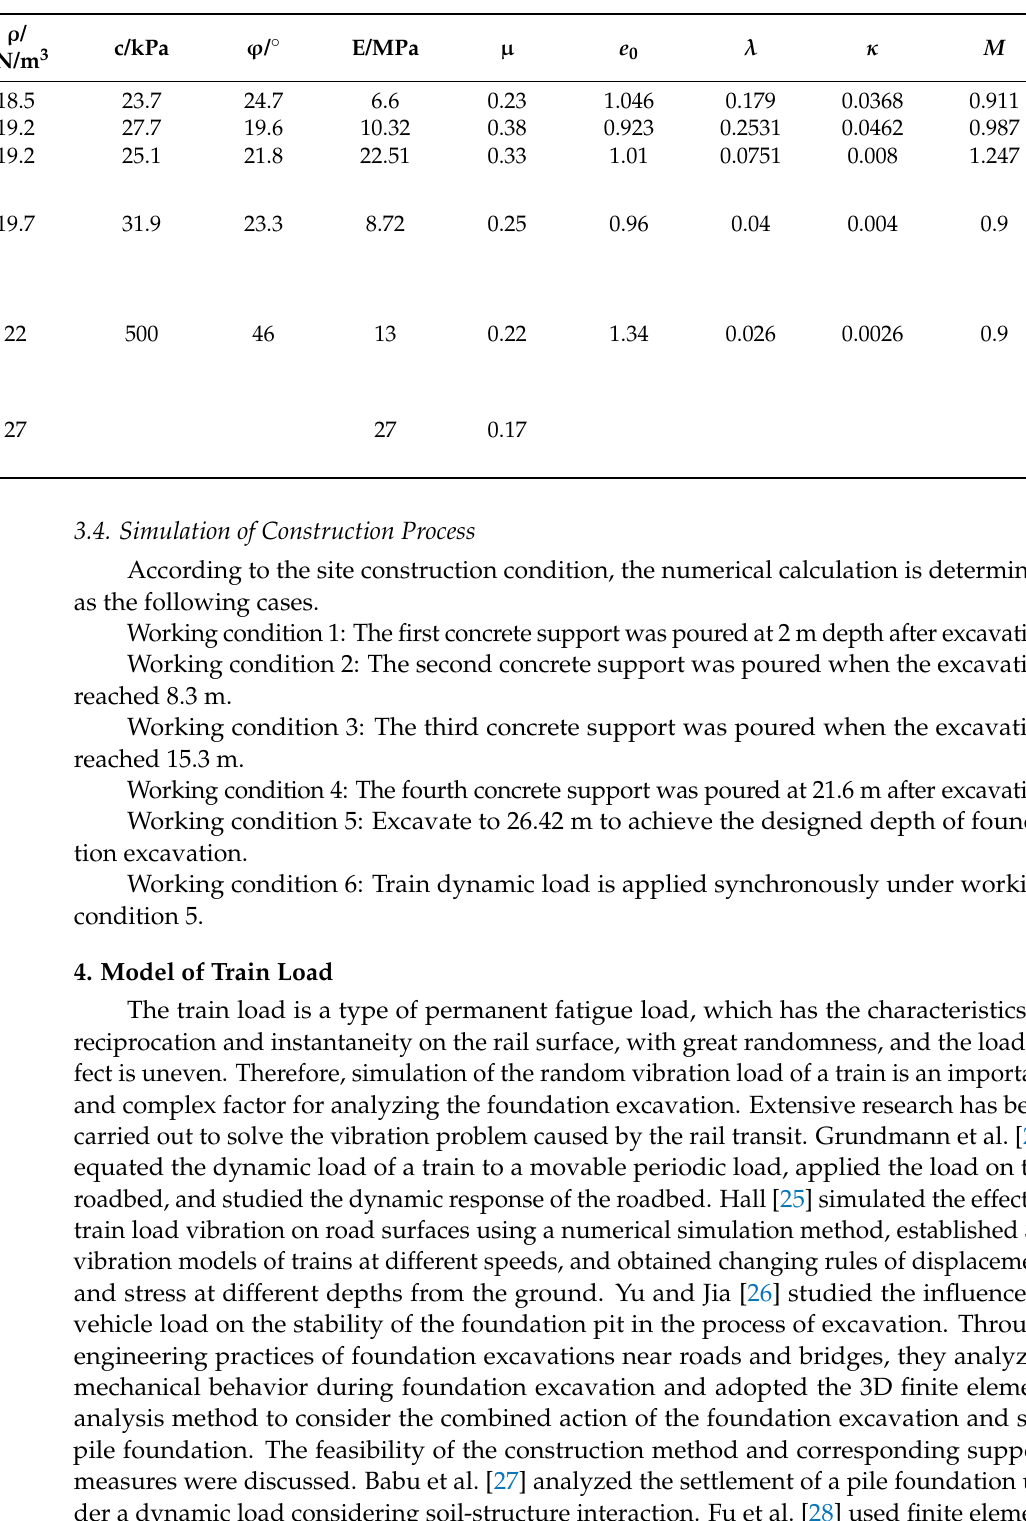
Table 1. Parameters of each soil